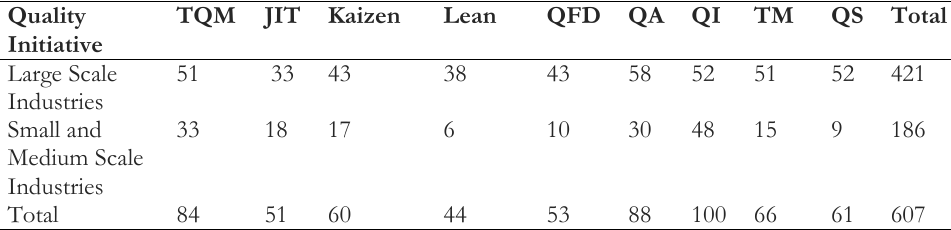
Table 1. Responses from firms in implementation of quality initiative.